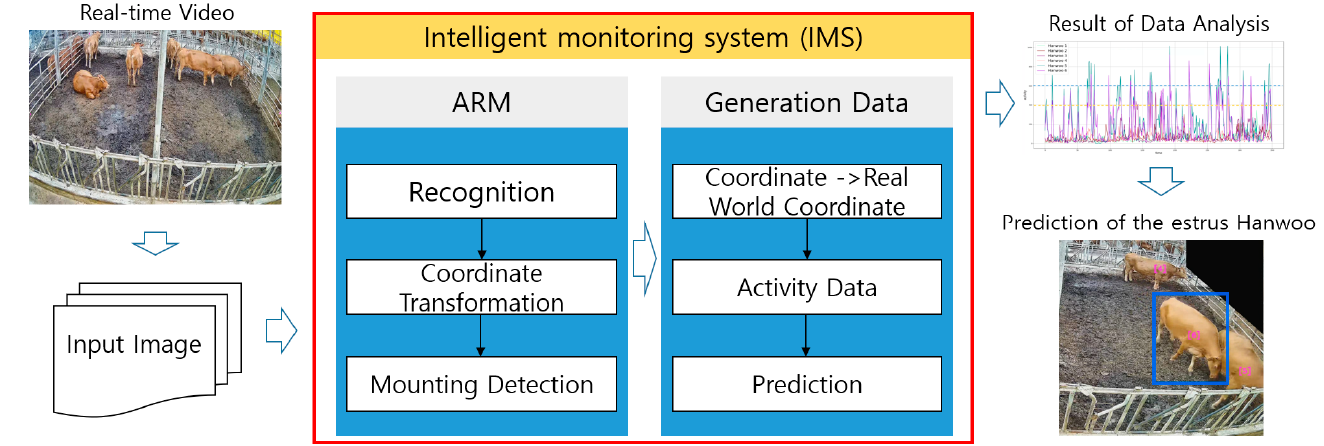
Figure 4. IMS structure and process with the ARM.